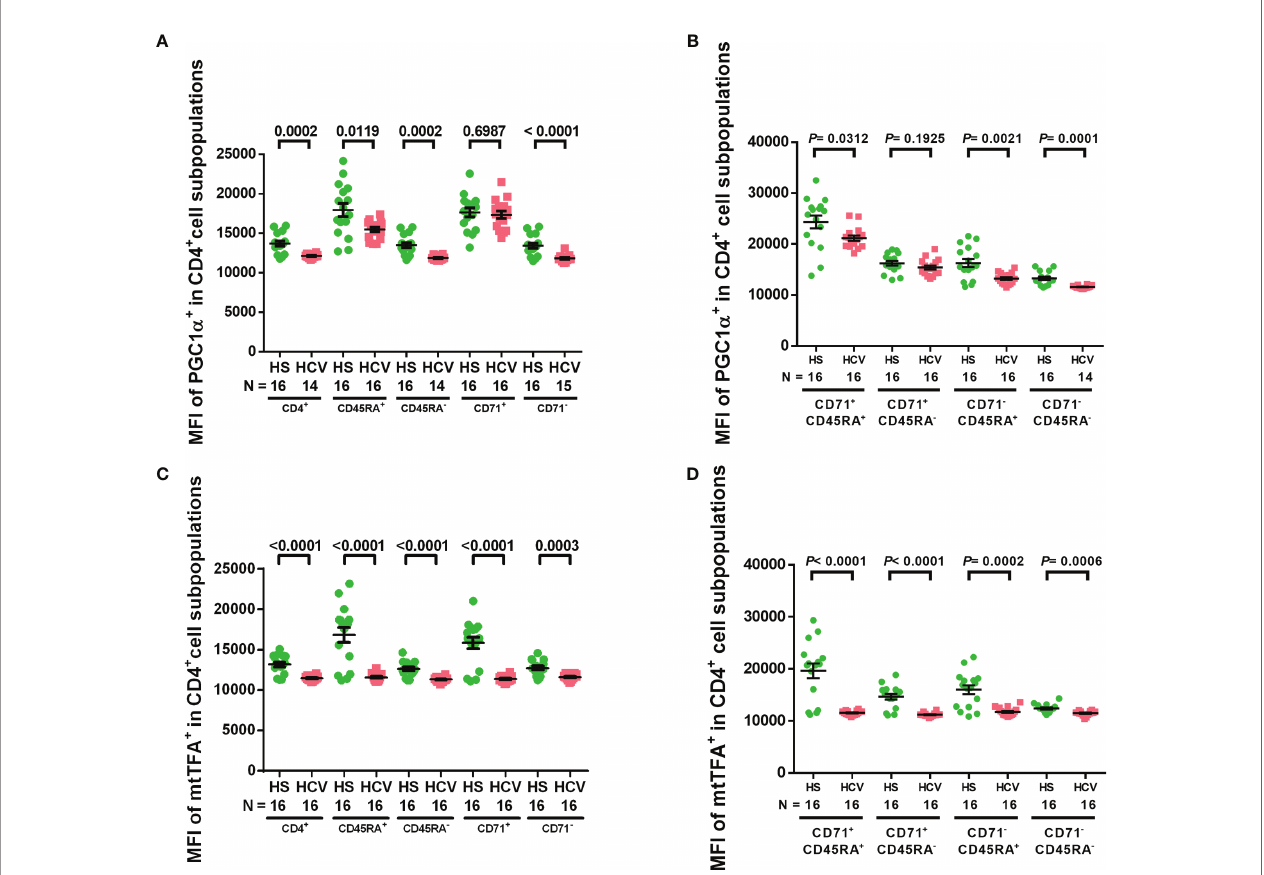
FIGURE 3 | PGC-1 a and mtTFA expressions in CD4 T cells from HCV-infected individuals and HS. (A, B) Flow cytometry analysis of the MFI of PGC-1 a + cells in total CD4 + , CD4 + CD45RA + , CD4 + CD45RA - , CD4 + CD71 + , CD4 + CD71 - , CD4 + CD71 + CD45RA + , CD4 + CD71 + CD45RA - , CD4 + CD71 - CD45RA + , CD4 + CD71 - CD45RA - cell subpopulations from HCV-infected individuals and health subjects (HS). (C, D) Flow cytometry analysis of the MFI of mtTFA + cells in total CD4 + , CD4 + CD45RA + , CD4 + CD45RA - , CD4 + CD71 + , CD4 + CD71 - , CD4 + CD71 + CD45RA + , CD4 + CD71 + CD45RA - , CD4 + CD71 - CD45RA + , CD4 + CD71 - CD45RA - cell subpopulations from HCV-infected individuals and HS. The data were analyzed by parametric unpaired T-tests with or without Welch ’ s corrections or nonparametric Mann-Whitney U